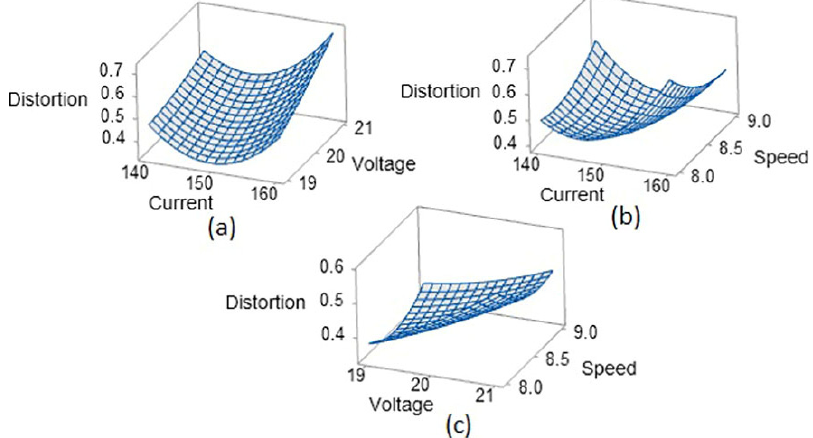
Figure 7. Response surfaces of weld parameters vs. distortion; ( a ) current and voltage; ( b ) current and speed; ( c ) voltage and speed.